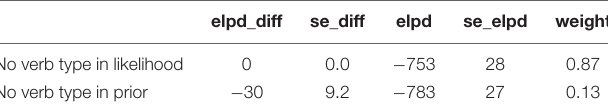
TABLE 11 | Model with no verb type in the likelihood compared to a model with no verb type on the